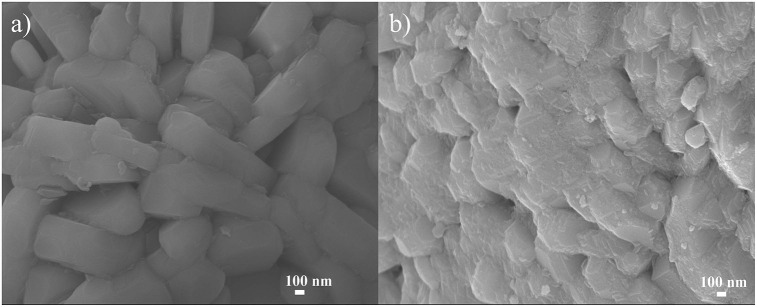
SEM images of (a) LNCM and (b) PLA-1-Al2O3@LNCM.